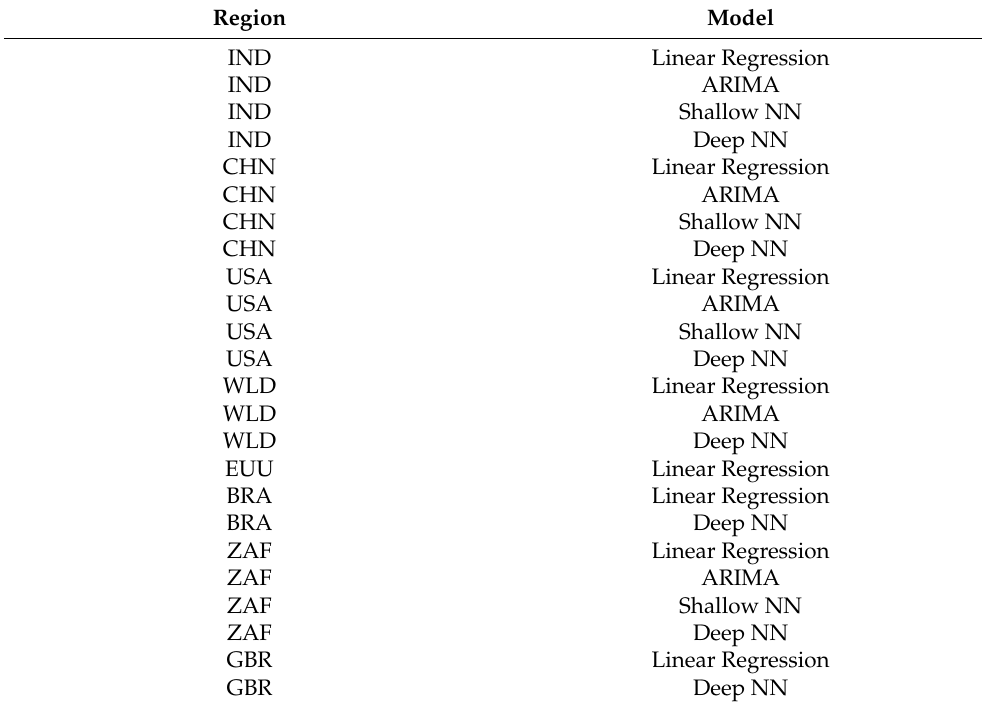
Table 15. Models that have failed the naïve model benchmark test, i.e., models whose test-MAPE is higher than that shown in Table